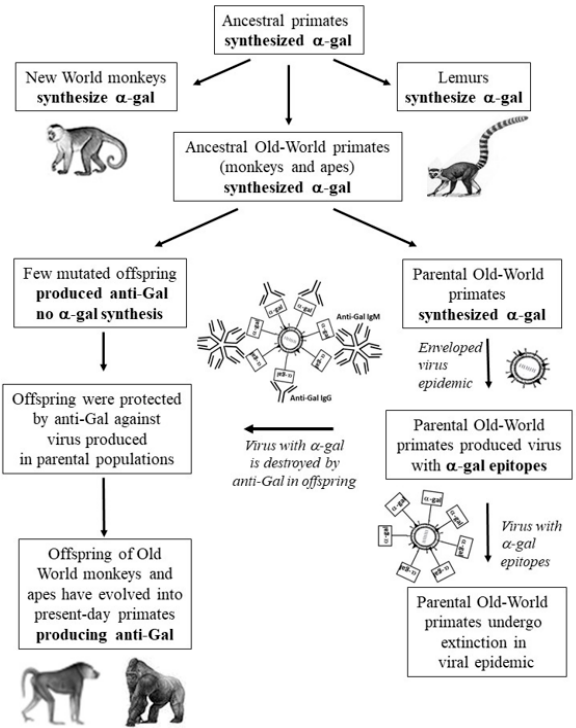
Figure 4. Hypothesis on the association between the evolutionary elimination of α -gal epitopes in ancestral Old World primates and an epidemic caused by a virus that was lethal to these ancestral primates. Early ancestral Old World primates synthesized α -gal epitopes, as New World monkeys, lemurs and non-primate mammals. Accidental base deletion mutation in one early Old World primate resulted in the inactivation of the α 1,3GT gene ( GGTA1 ). After few generations, a small offspring population homozygous for this inactivating mutation produced the natural anti-Gal antibody. An epidemic by a lethal virus caused the extinction of the parental populations synthesizing α -gal epitopes. The virus produced in parental populations presented multiple α -gal epitopes on the glycan shield (“ α -gal” in the rectangles). Anti-Gal in individuals of the mutated population protected against the virus by binding to the α -gal epitopes on its glycan shield. This ultimately resulted in the replacement of the parental populations synthesizing α -gal epitopes with Old World primate progeny lacking this epitope and producing the natural anti-Gal antibody. Modified from ref. [89].